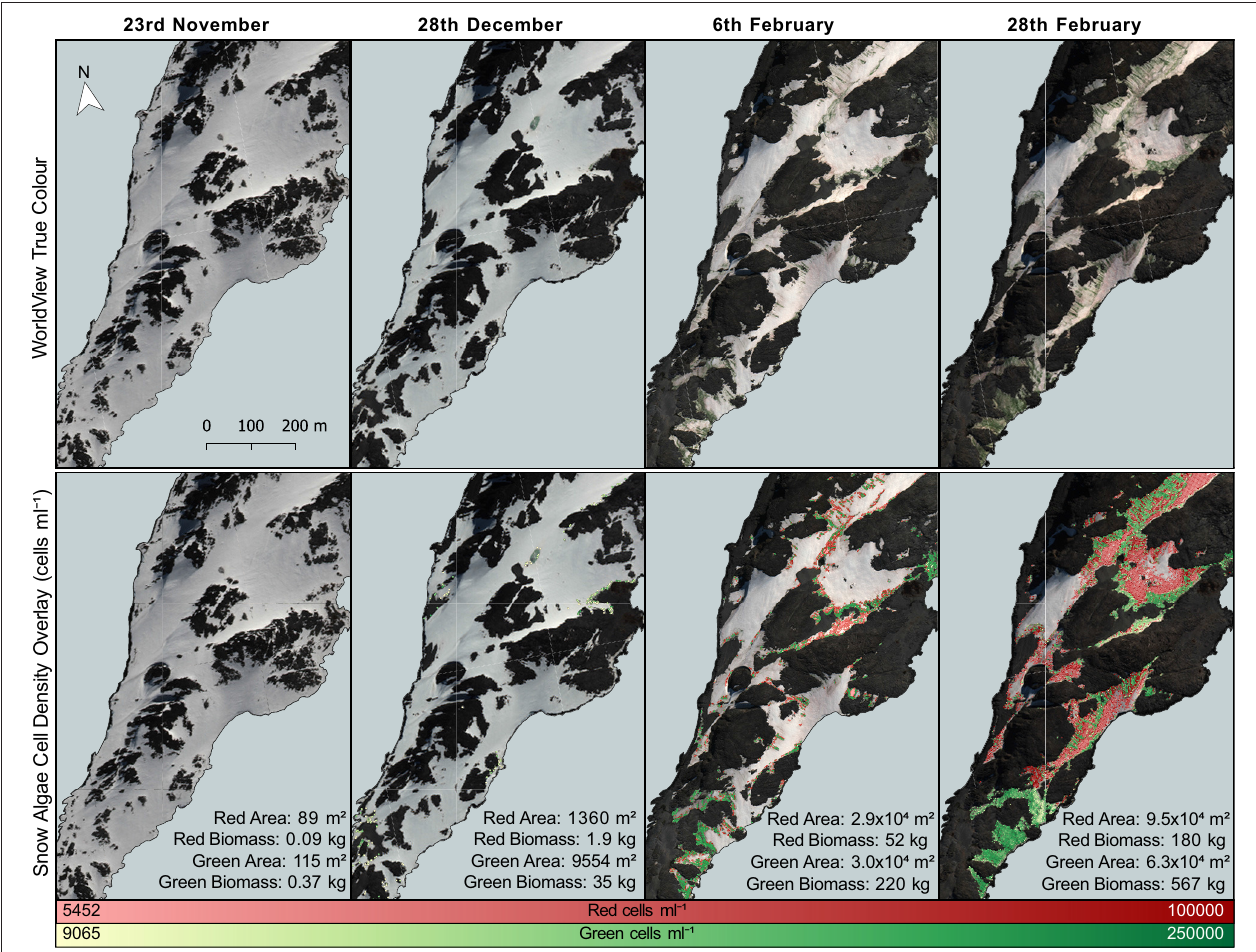
FIGURE 9 | Red and green snow algal distribution and modeled cell density. Area coverage and (dry) biomass estimates are given for red and green snow algae on Anchorage Island. All images are from 2017. Map extent is shown in Figure 1B .